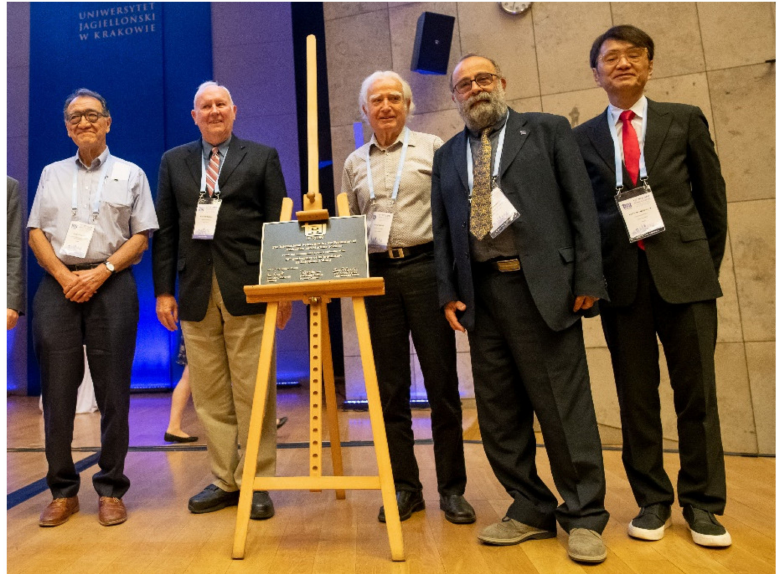
Figure 5. The living Past IFToMM Presidents with the commemorative plaque in exhibition. (from left to right): Prof. Jorge Angeles, Prof. Kenneth Waldron, Prof. Bernard Roth, Prof. Marco Ceccarelli, and Prof. Yoshihiko Nakamura.